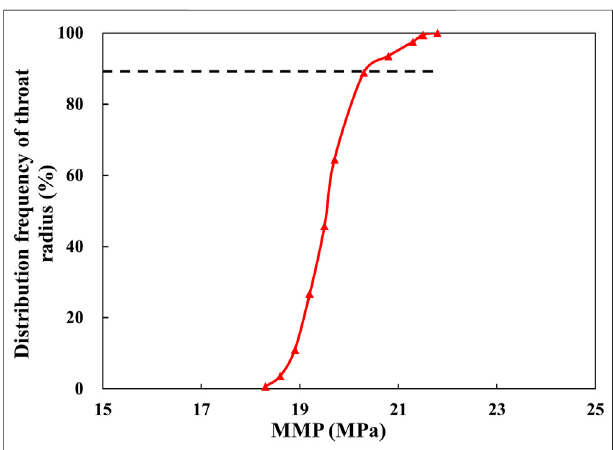
FIGURE7| Minimummisciblepressurecumulativedistribution